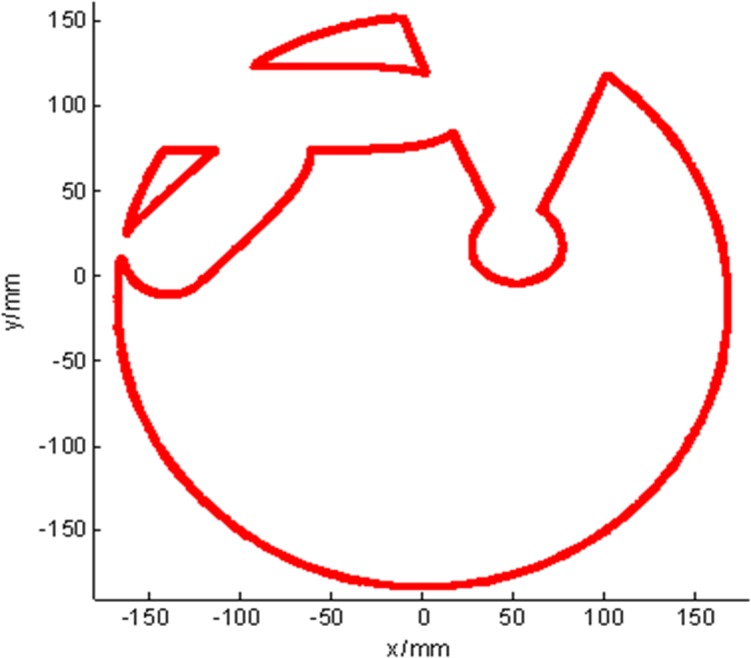
The needle2 CFRW.